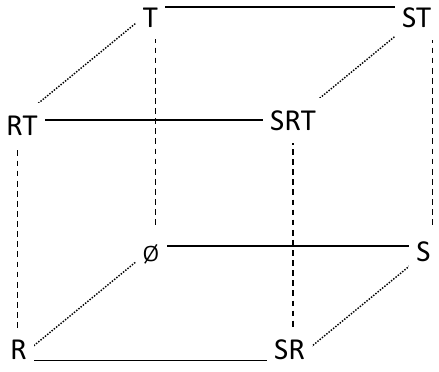
Figure 1. Initial model of the